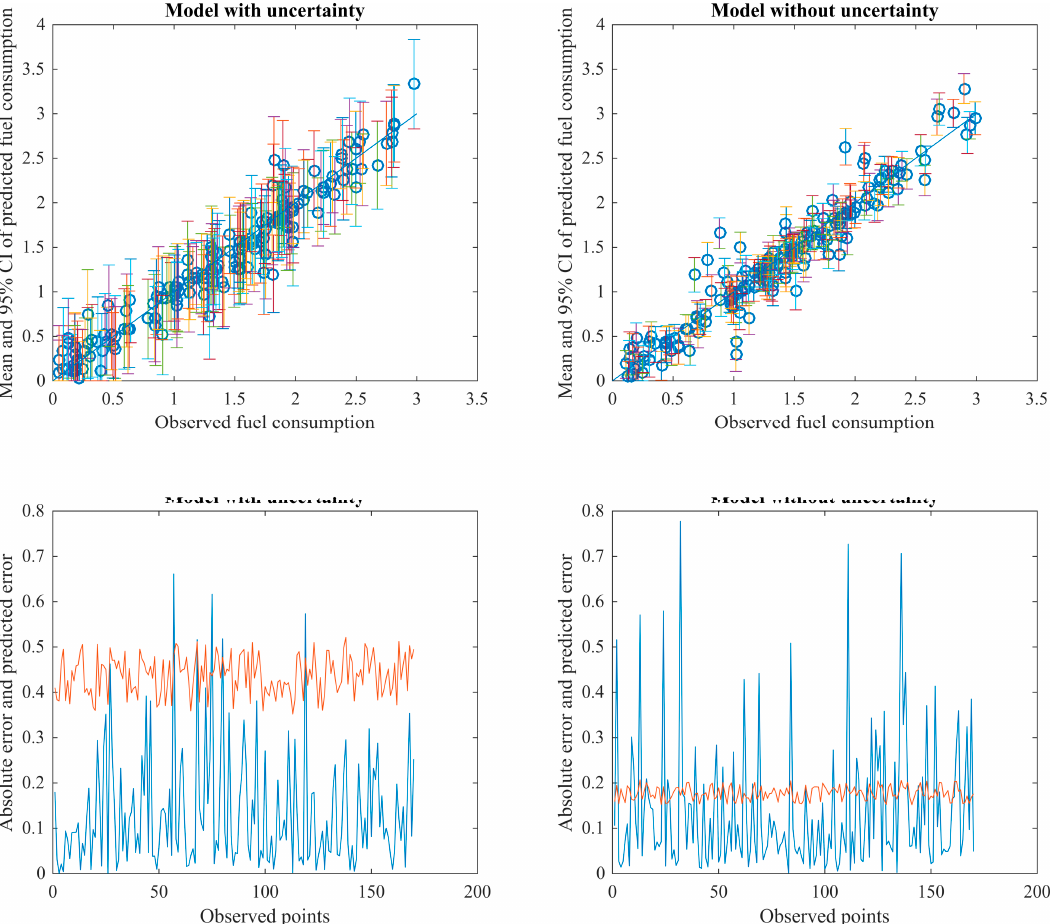
Figure 3. Predicted versus observed results for the validation data. The first row shows the mean and 95% CI of the predicted versus the real observed fuel consumptions, with ( left ) and without ( right ) considering input uncertainty. The second row shows the absolute error between the predicted mean fuel consumptions and the real observation (blue line), as well as the predicted error (half of the 95% CI, orange line), both with ( left ) and without ( right ) considering input uncertainty.